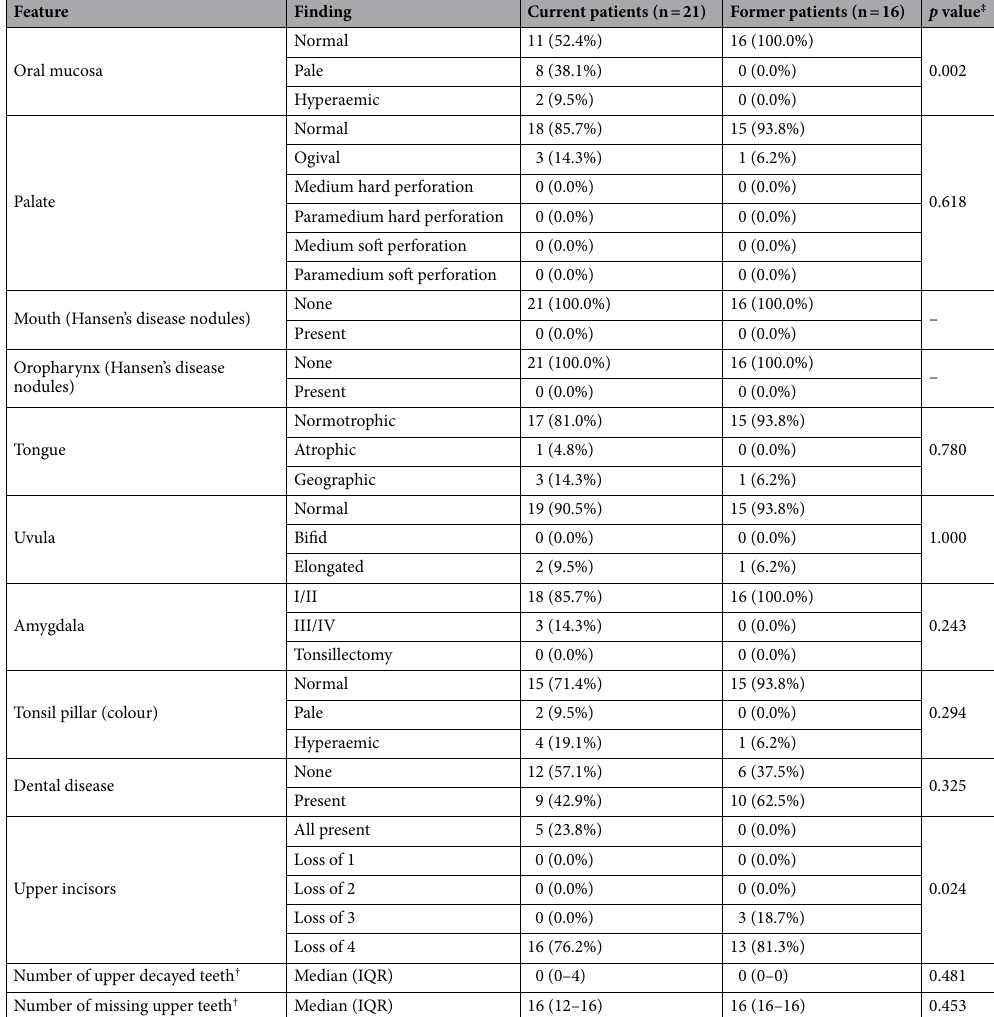
Table 3. Oroscopic findings in current and former Hansen’s disease patients. ‡ Fisher’s exact (categorical variables) or Kruskal–Wallis test (number of decayed or missing upper teeth). † Not included in oroscopic examination score—all other features included, scored as 0 for none/normal, 1 for any other